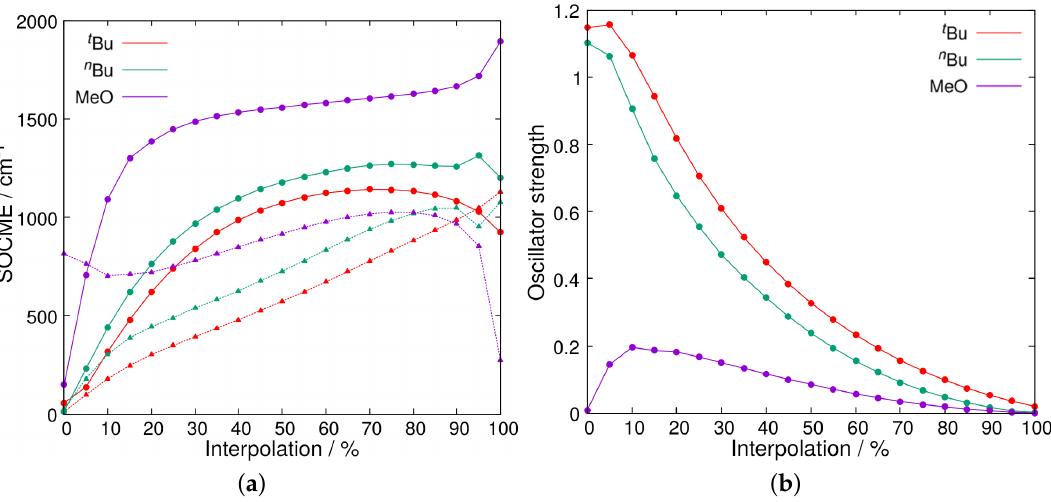
Figure 9. ( a ) Spin–orbit coupling matrix elements |(cid:104) T 1 | ˆ H so | S 0 (cid:105)| (dotted lines) and |(cid:104) T 1 | ˆ H so | S 1 (cid:105)| (solid lines) and ( b ) oscillator strengths of the S 1 ← S 0 transitions along linearly interpolated paths connecting the S 0 minimum (0%) and the optimized S 1 geometry